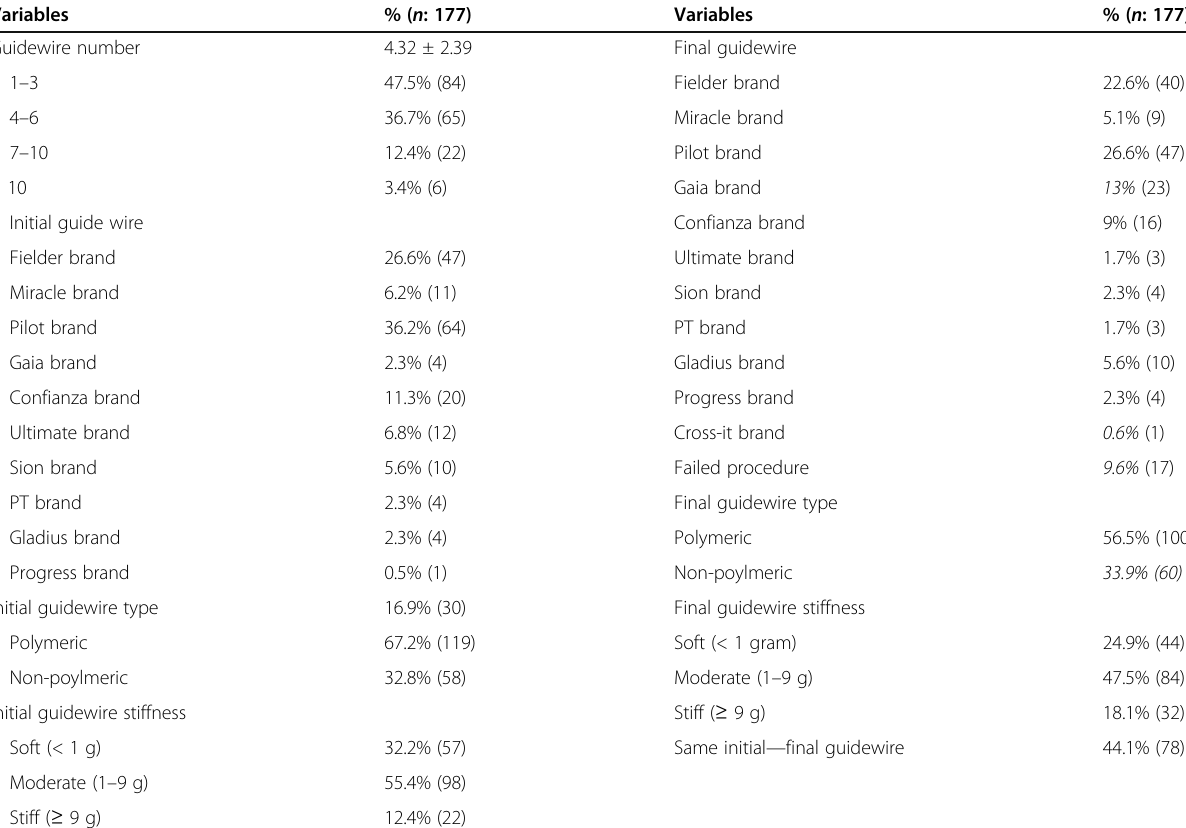
Table 2 Type and structural features of 0.014 inch coronary guidewires used for chronic total occlusion procedure